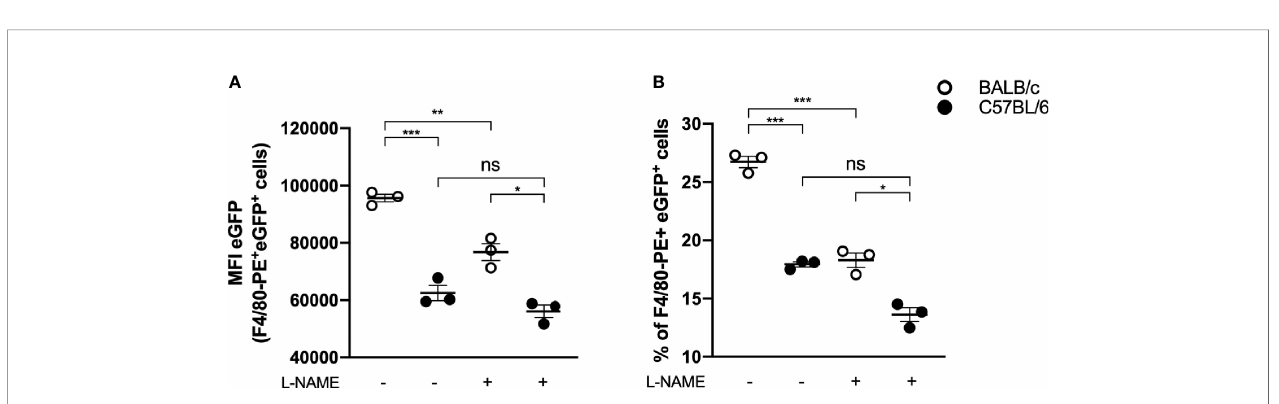
FIGURE 6 | In vitro infection of BALB/c and C57BL/6 peritoneal macrophages. Peritoneal macrophages (10 5 ) of BALB/c and C57BL/6 mice were infected with 10 6 e-GPF parasites and evaluated about (A) e-GFP median fl uorescence intensity (MFI) of macrophages (F4/80 + cells) and (B) percentage of infected macrophages (% of F4/80 + and e-GFP + cells). Data represent the mean ± SEM of three independent experiments performed in duplicate. * Signi fi cant difference p ≤ 0.05, **p ≤ 0.01, ***p ≤ 0.001. L-NAME, N(omega)-Nitro-L-arginine methyl ester; NS, nonsigni fi